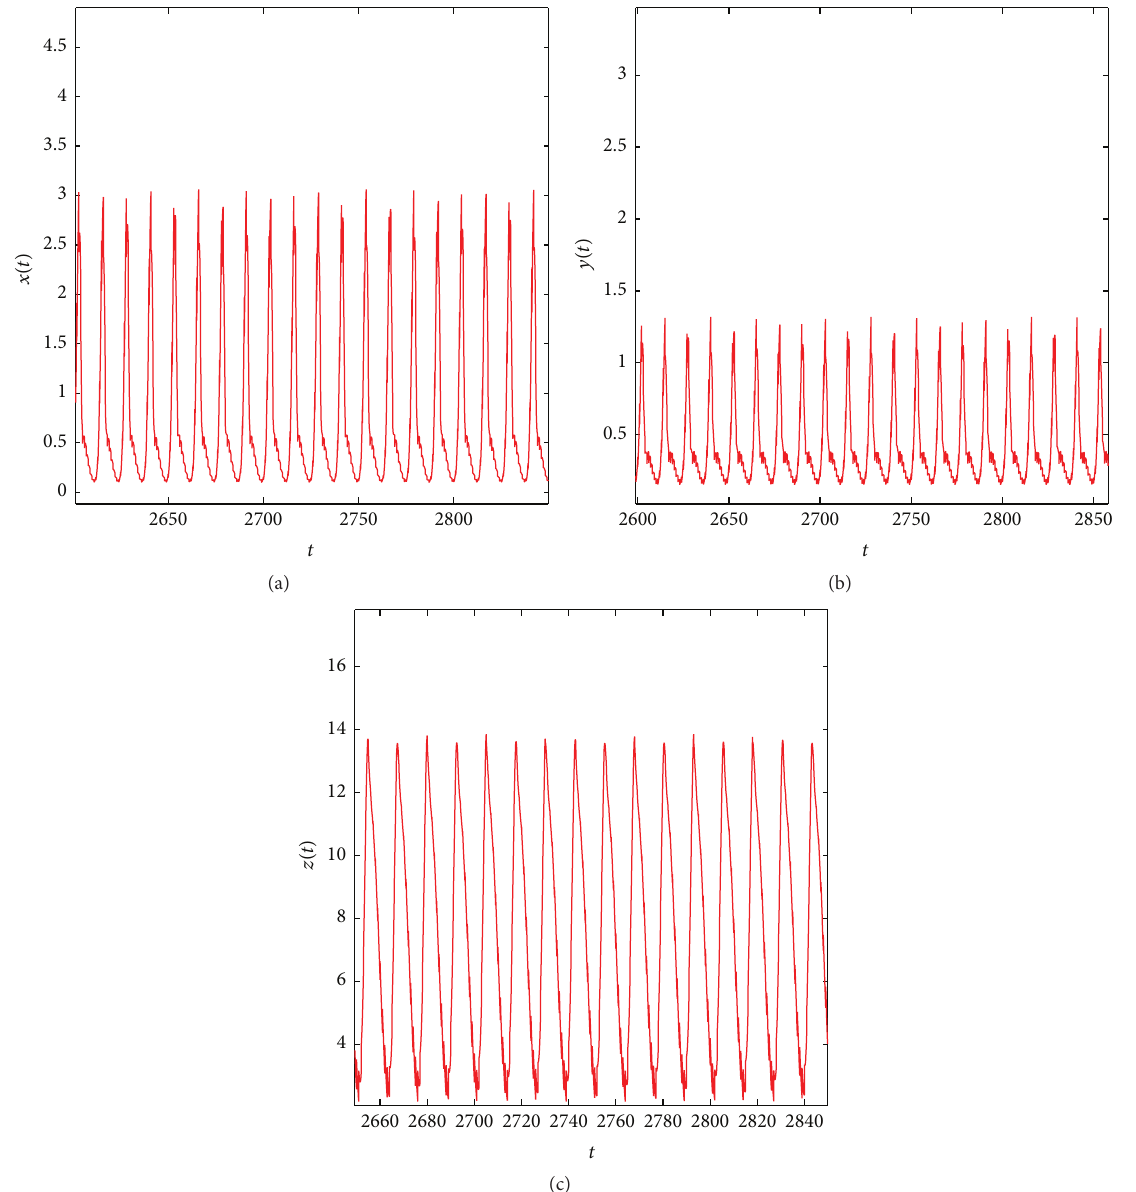
Figure 8: (a)–(c) Time series of pests 𝑥(𝑡) and 𝑦(𝑡) depicting decreased biomass level while time series of predator 𝑧(𝑡) exhibits increased biomass level of system (2) with mixed Holling type III functional responses in presence of seasonal perturbation with data set (45) and 𝑃 = 1.2 .